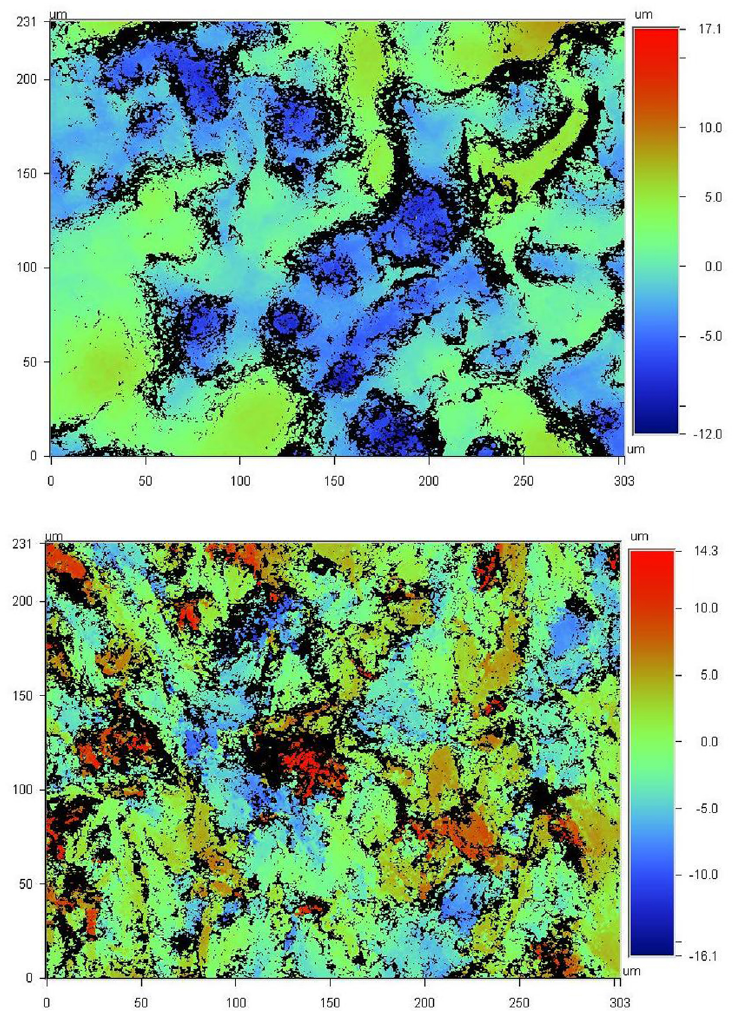
Figure 3- Vertical scan images by a non-contact optical interferometric profilometer at 20.4× magnification of PMMA (upper) and Polyamide (lower) denture base material with Ra values of 2.58 nm and 3.01 nm, respectively. Cool colors indicate depth and warm colors height